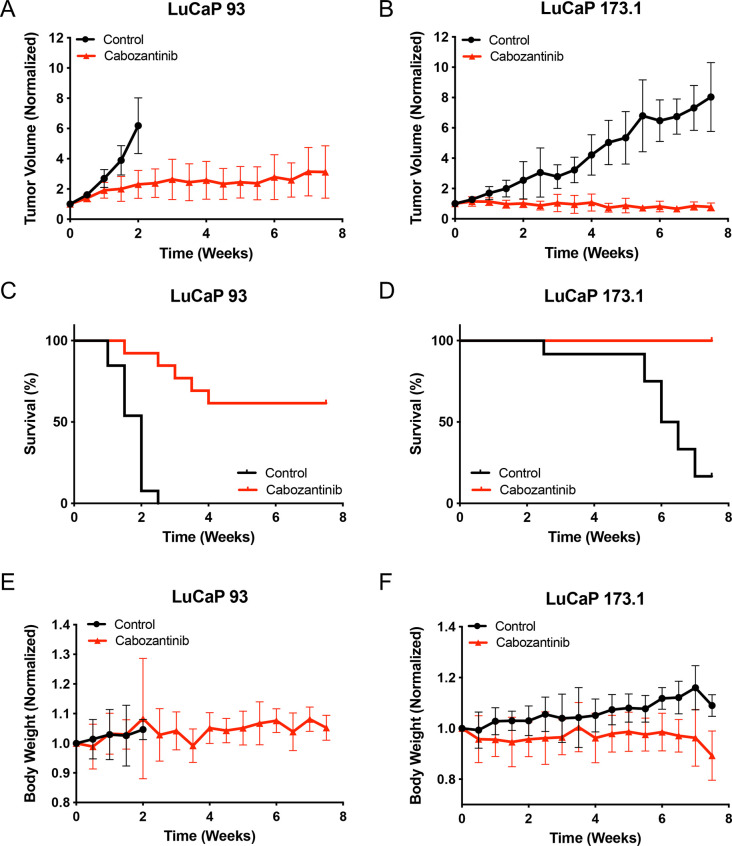
Cabozantinib significantly decreases tumor volume and prolongs survival in SCNPC PDX models.SCNPC PDX models were treated with 30 mg/kg of cabozantinib (LuCaP 93, n = 14; LuCaP 173.1 n = 14) or vehicle control (LuCaP 93, n = 14; LuCaP 173.1, n = 14) for up to 7.5 weeks. (A) LuCaP 93 and (B) LuCaP 173.1 normalized tumor volume measurements. LuCaP 93, p-value = 0.0175; LuCaP 173.1, p-value <0.0001. (C) LuCaP 93 and (D) LuCaP 173.1 overall survival curves using Kaplan-Meier analysis and the log-rank (Mantel-Cox) test. LuCaP 93, p-value < 0.0001; LuCaP 173.1, p-value < 0.0001. (E) LuCaP 93 and (F) LuCaP 173.1 normalized body weight measurements. LuCaP 93, p-value = 0.1677; LuCaP 173.1, p-value <0.0002. Black = control vs. red = cabozantinib.